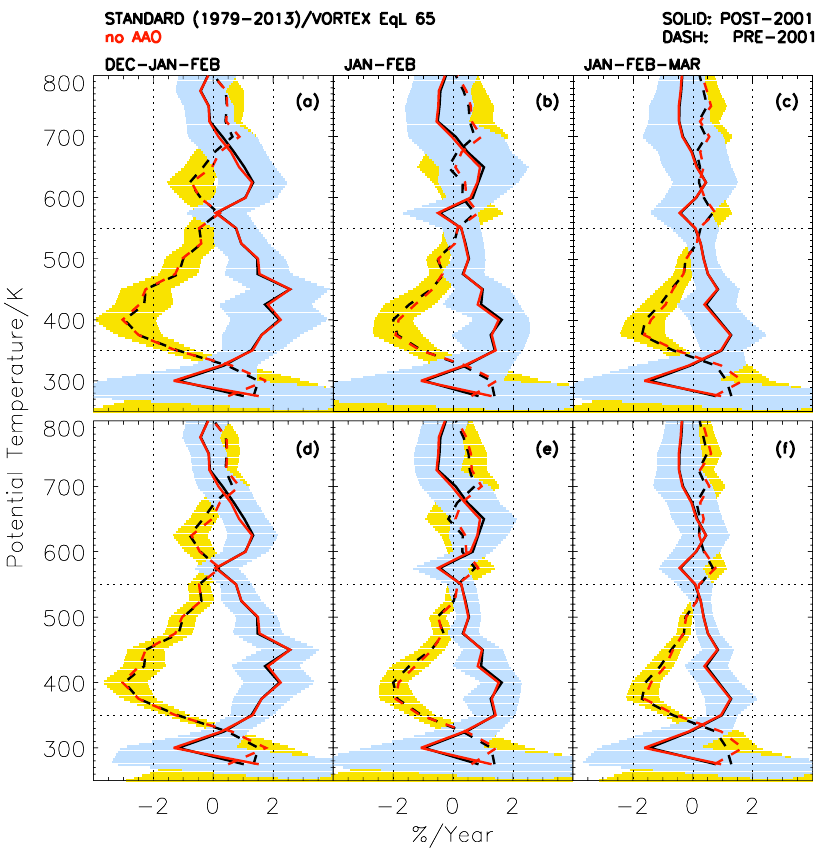
Figure 3. Vertical structure of ozone trends in Antarctic Summer: ( a ) Vortex averaged ( ≥ 65° S EqL) ozone trends estimated from ozonesonde measurements in Antarctica for ( a) December–January–February (DJF), (b) January–February (JF) and (c) January–February–March (JFM) seasons. The shaded areas represent their significance at the 95% level ( a – c , upper panel) and 85% level ( d – e , lower panel). The red curves represent the analyses without considering the influence of the Antarctic Oscillation. Note that the number of observations in summer (DJF, JF and JFM) is significantly fewer than those in spring (SON, Fig. 2). In all plots ( a – f ) the horizontal dotted lines represent 350 K (~12 km) and 550 K (~22 km) altitudes and vertical dotted lines represent − 2%/year and